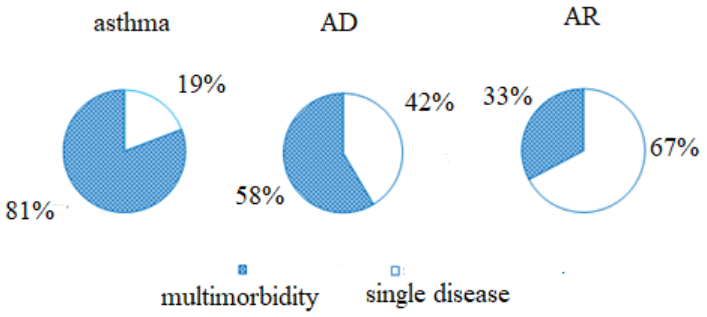
Figure 4. Ratio of single versus multiple disease symptoms.